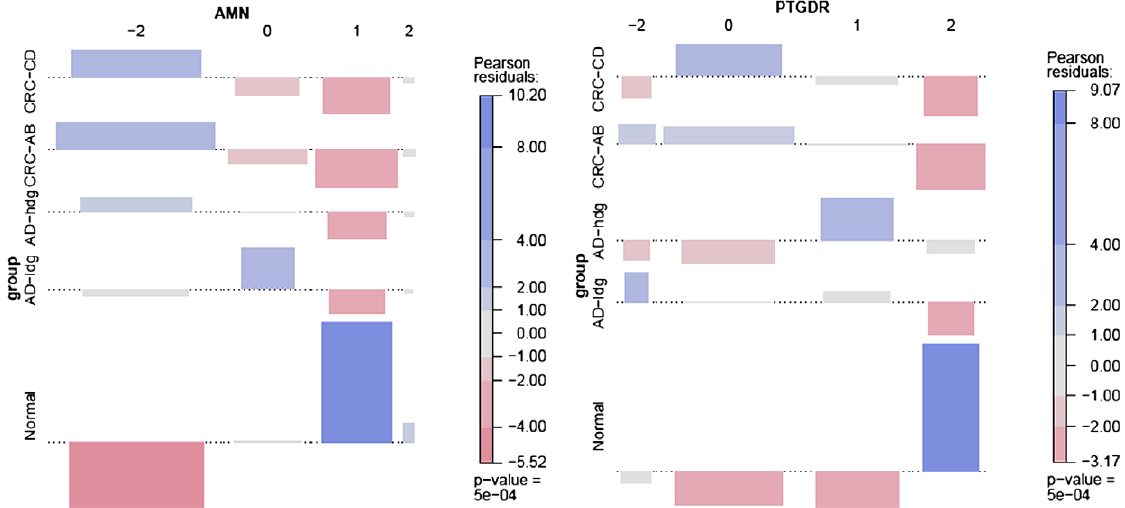
Fig. 3. Association plots representing amnionless homolog and prostaglandin D2 receptor protein expression detected by TMA in the subgroups. To measure the association of two variables (expression and disease stage) the Chi-square test statistic – the sum of the squared Pearson residuals – was used. When the difference was statistically significant ( p < 0 . 05), more detailed analysis was visualized on the basis of the Pearson residuals. The darker the intensity of the blue columns, the stronger the statistical significance at the given immunostaining intensity score. The height of the blue columns represents the number of cases belonging to the given score. Immunostaining scores: In case of PTGDR: − 2 = no staining; 0 = weak staining; 1 = moderate staining; 2 = strong diffuse epithelial cytoplasmatic immunostaining; in case of AMN: − 2 = no or weak apical epithelial cytoplasmatic staining; 0 = moderate apical cytoplasmatic staining, 1 = strong apical and weak basal cytoplasmatic staining; 2 = strong diffuse epithelial cytoplasmatic immunostaining. AMN = amnionless homolog, PTGDR = prostaglandin D2 receptor, CRC-CD = colorectal cancer Dukes C or D stage, CRC-AB = colorectal cancer Dukes A or B stages, AD-hdg = adenoma with high-grade dysplasia, AD-ldg = adenoma with low-grade